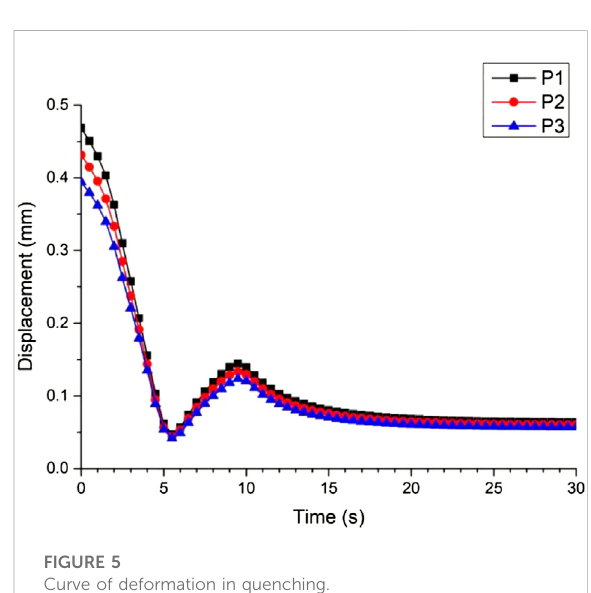
FIGURE 5 Curve of deformation in quenching.